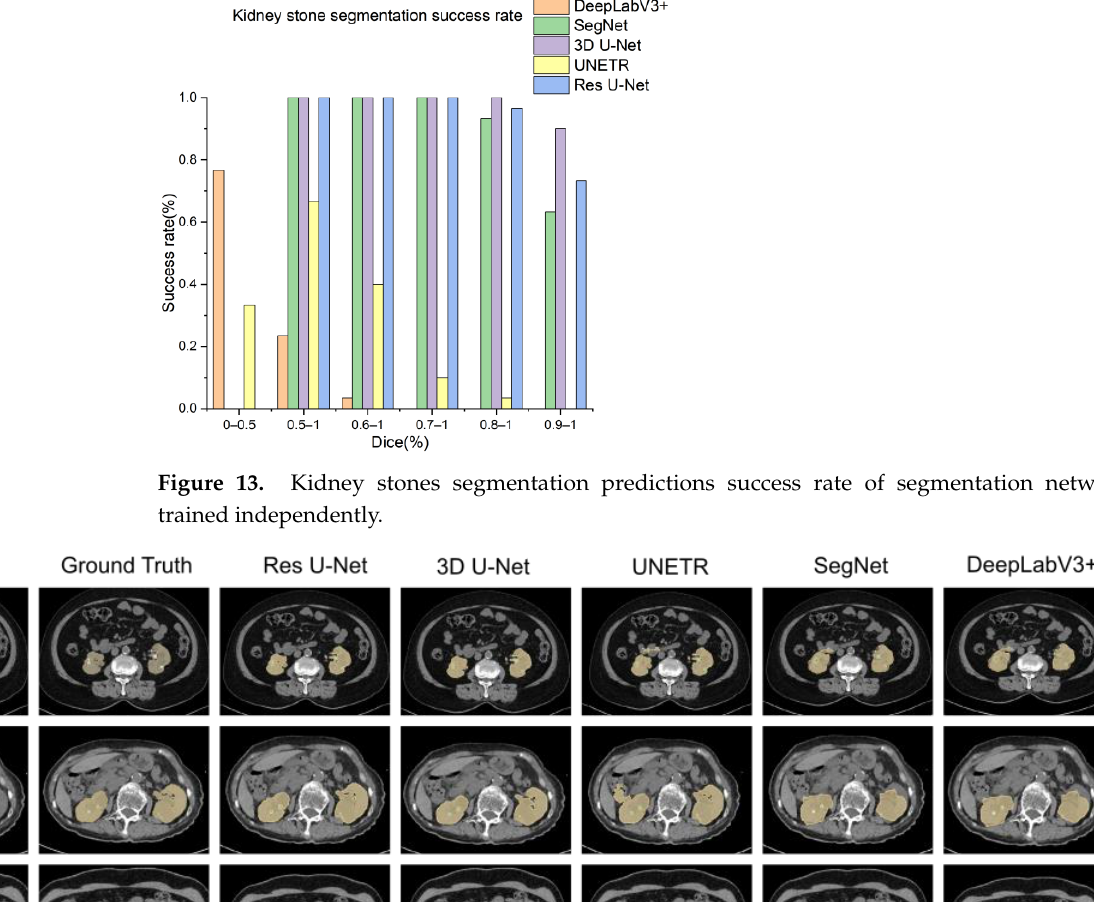
12 of 18 Figure 11. Kidney segmentation success rate of segmentation networks trained independently.